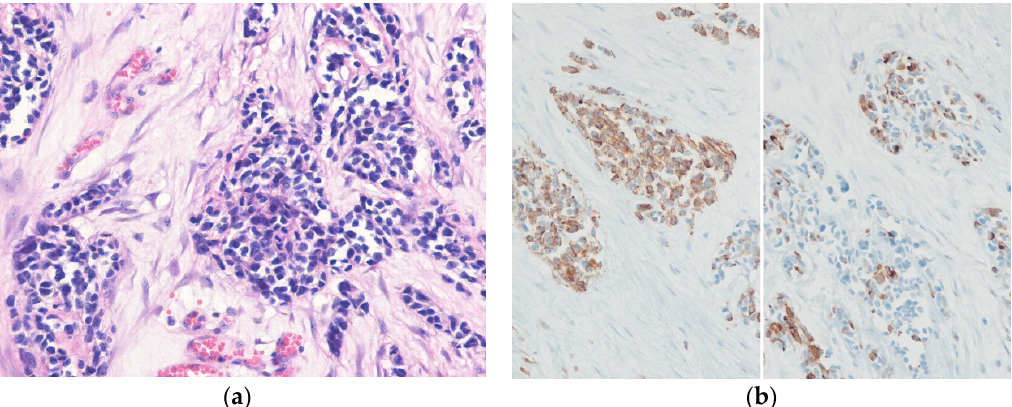
Figure 11. Desmoplastic small round cell tumor. ( a ) The tumor shows nests of small round tumor cells within desmoplastic fibrous stroma. ( b ) The tumor cells are positive for cytokeratin (AE1/AE3) (left) and show perinuclear dot-like expression for desmin (right) (H&E stain, original magnification 200× a ; cytokeratin (AE1/AE3) and desmin immunostain, original magnification 200× b